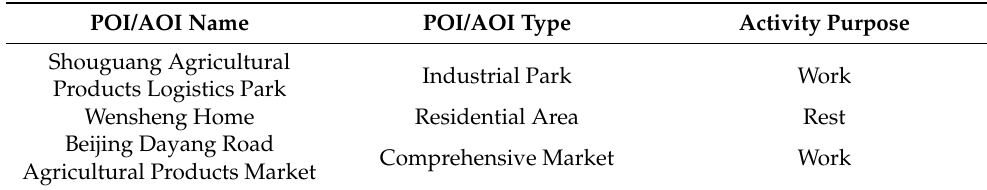
Table 1. Relationship between POI/AOI types and the purpose of freight activities.